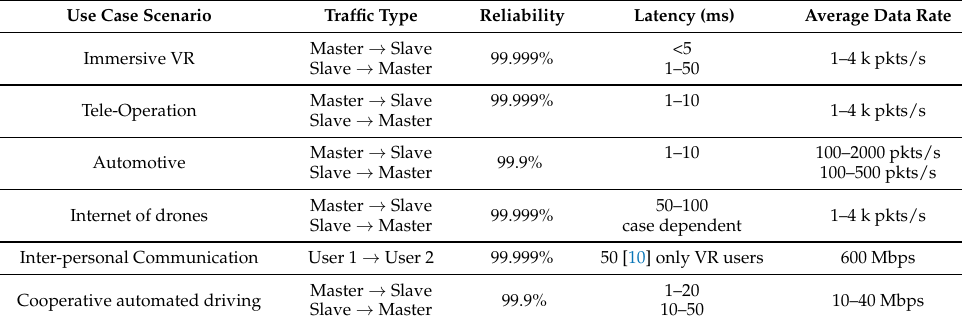
Table 1. TI requirements and characteristics for specific use cases